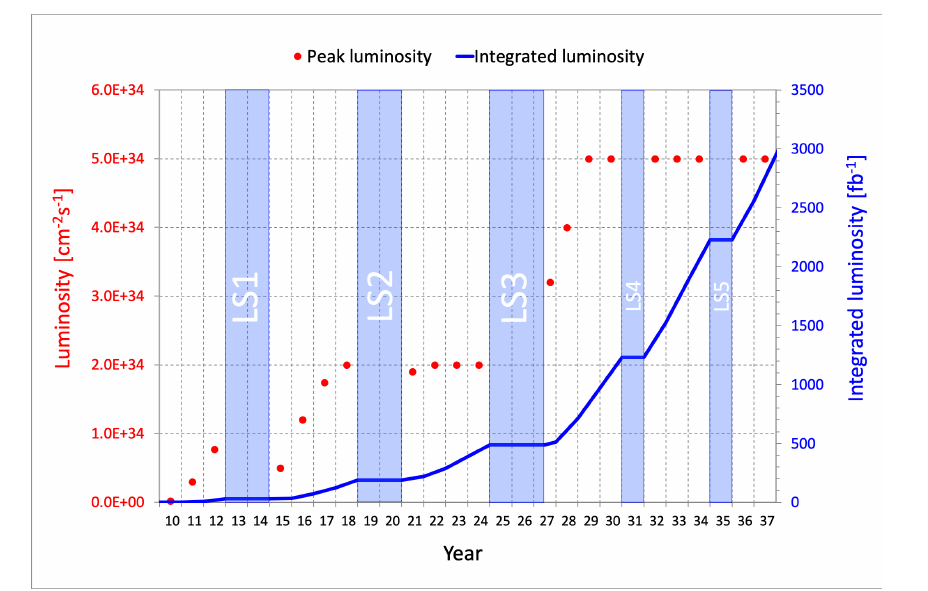
Figure 1. LHC luminosity in Run1 and Run2 compared to predictions for Run3 and for High Lumi LHC